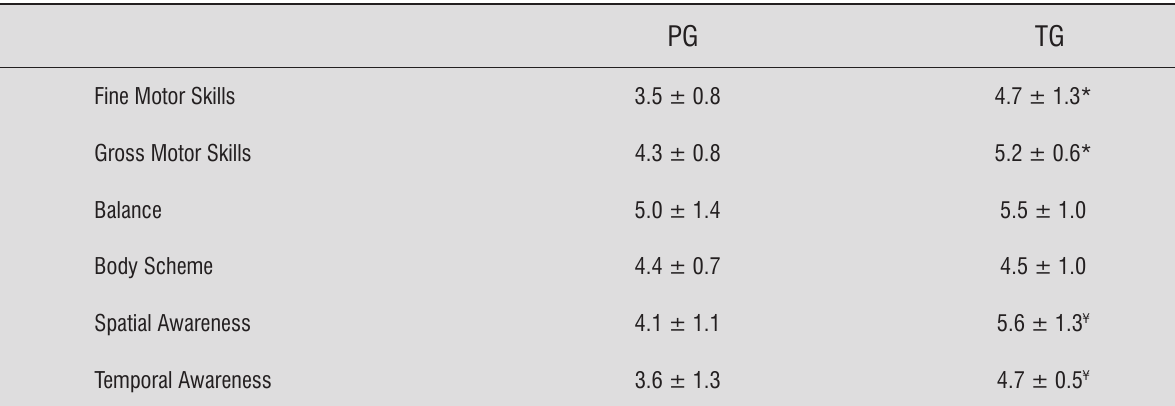
Table 1 - Comparison of Fine and Gross Motor Skills, Balance, Body Scheme Spatial and Temporal Awareness between the Preterm (PG) and Term Groups